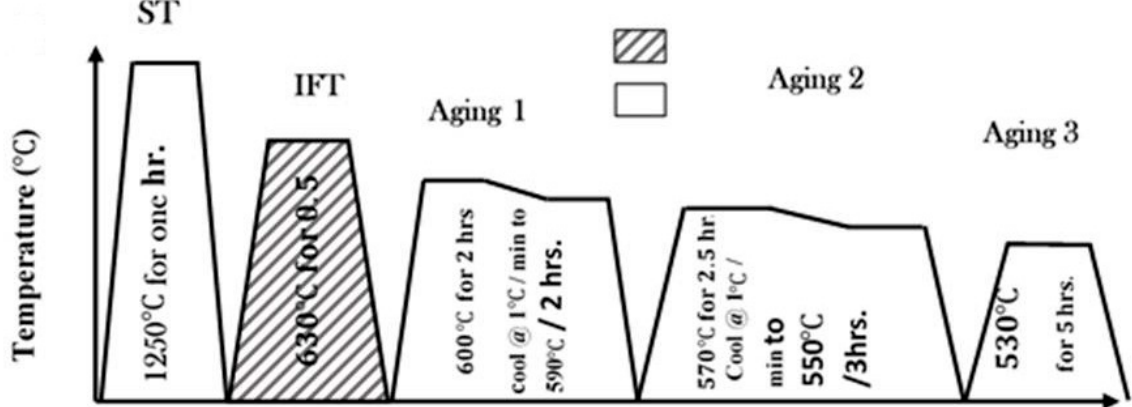
Figure 1. The processing flow chart for the alloys (40 + x)Fe–28Cr–(26 − x)Co–3Mo–1Ti–2V.